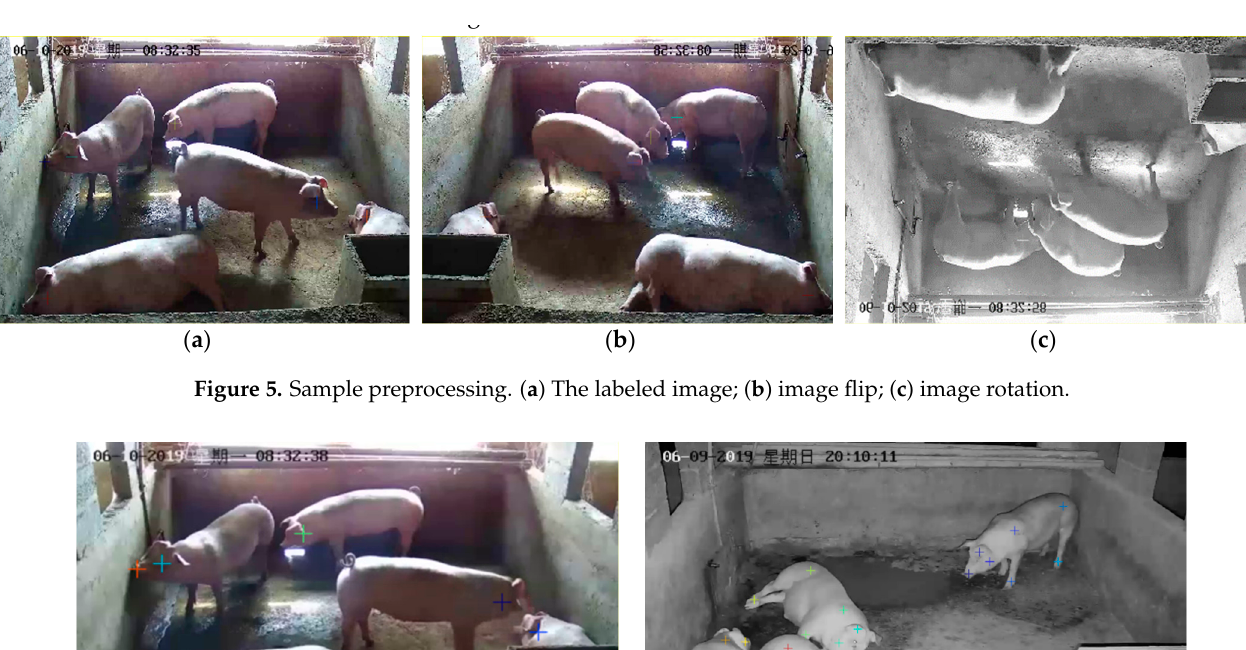
( b ) Figure 4. Trajectory tracking error of DLC. ( a ) is marked “++++” to identify the main parts of the piglet, such as its eye, snout, ear, and leg, and the tracking results are marked as “ ”; ( b ) represents the video trajectory tracking results. First, the labeling information should be enriched to improve the accuracy of the training model for reducing the number of manually labeled samples. In this study, only